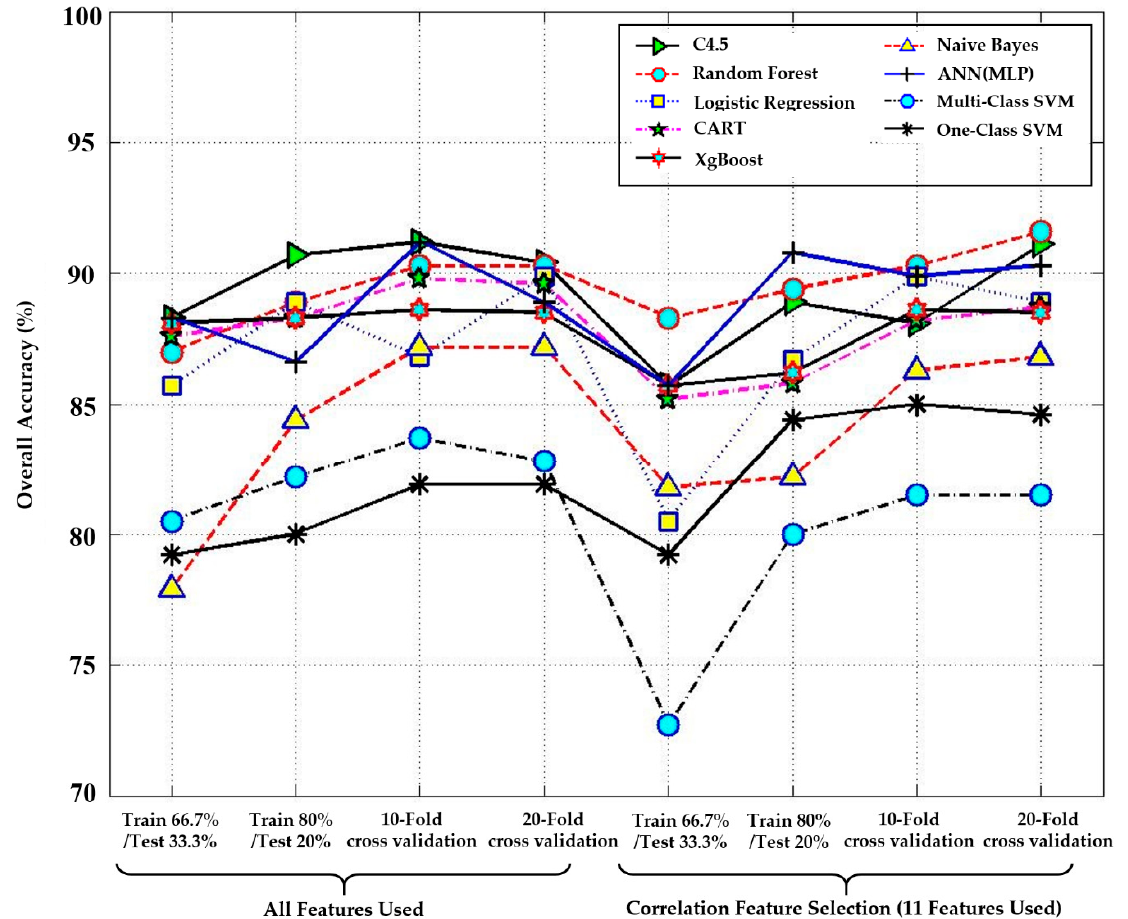
Figure 2. The Performance evaluation of the overall accuracy with various datasets.